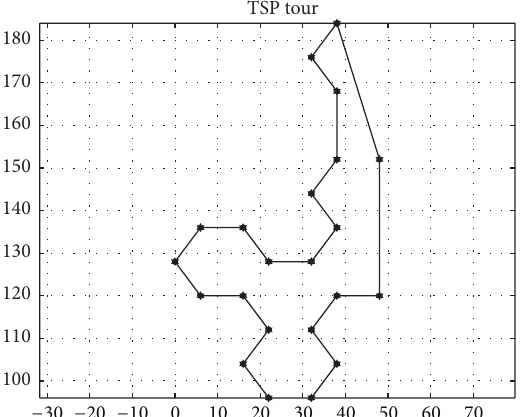
Figure 7: Generated tour in a drifting landscape for the best optimal